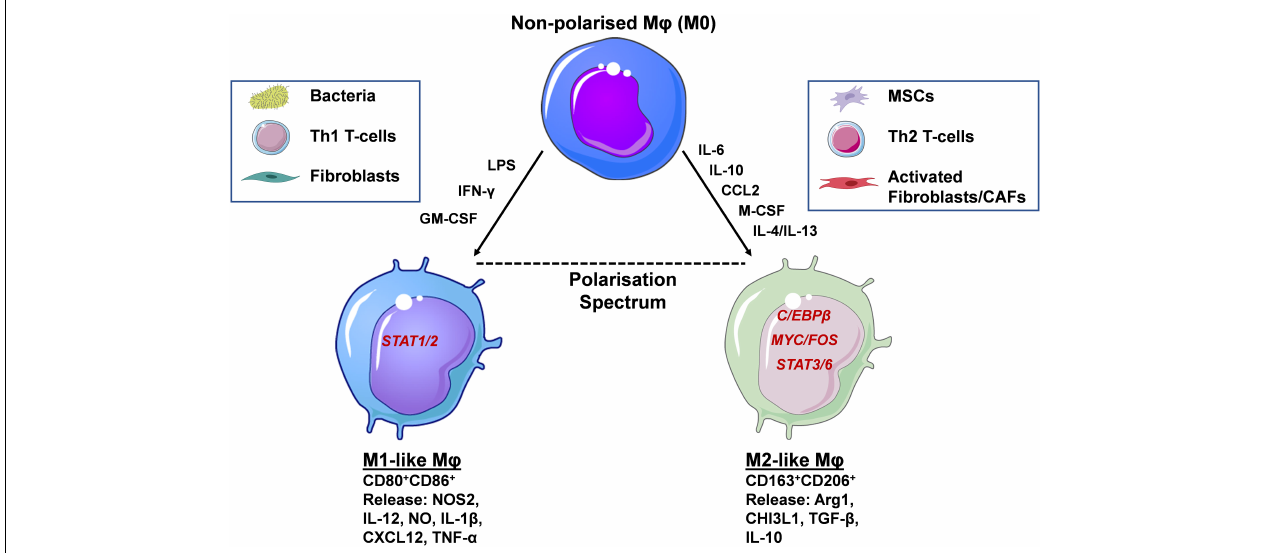
FIGURE 2 | Macrophage polarisation occurs via activation of distinct transcription factors and determines their function. Macrophages (M ϕ s) are highly plastic cells, adopting phenotypic and functional states that can be classified along a polarisation spectrum. At the two opposite ends of this spectrum lie the M1-like and M2-like M ϕ s. The former are induced by the presence of inflammatory mediators (e.g., LPS, IFN- γ , GM-CSF), signalling through STAT1/2, and display expression of CD80 and CD86 cell surface markers. Soluble, pro-inflammatory mediators released resemble Th1-like cytokines such as IL-12, IL-1 β and TNF- α . Functional polarisation towards an M1-like phenotype occurs in the presence of bacteria, Th1 T-cells and fibroblasts and their respective secreted factors. At the other end of the spectrum lie alternatively activated M2-like M ϕ s, induced by IL-6, IL-10, M-CSF, CCL2, and IL-4/IL-13 released by mesenchymal stem/stromal cells (MSCs), Th2 T-cells and fibroblasts/cancer associated fibroblasts (CAFs). The main transcription factors involved in M2-like polarisation are C/EBP β , MYC/FOS, and STAT3/6. Their secretome includes a number of anti-inflammatory, Th2-like mediators, such as Arg1, TGF- β and IL-10. Cell-surface expression of CD163 and CD206 distinguish M2-like from M1-like M ϕ s and have the potential to be used as prognostic markers in a number of human cancers, including AML (created using Servier Medical Art; Created using